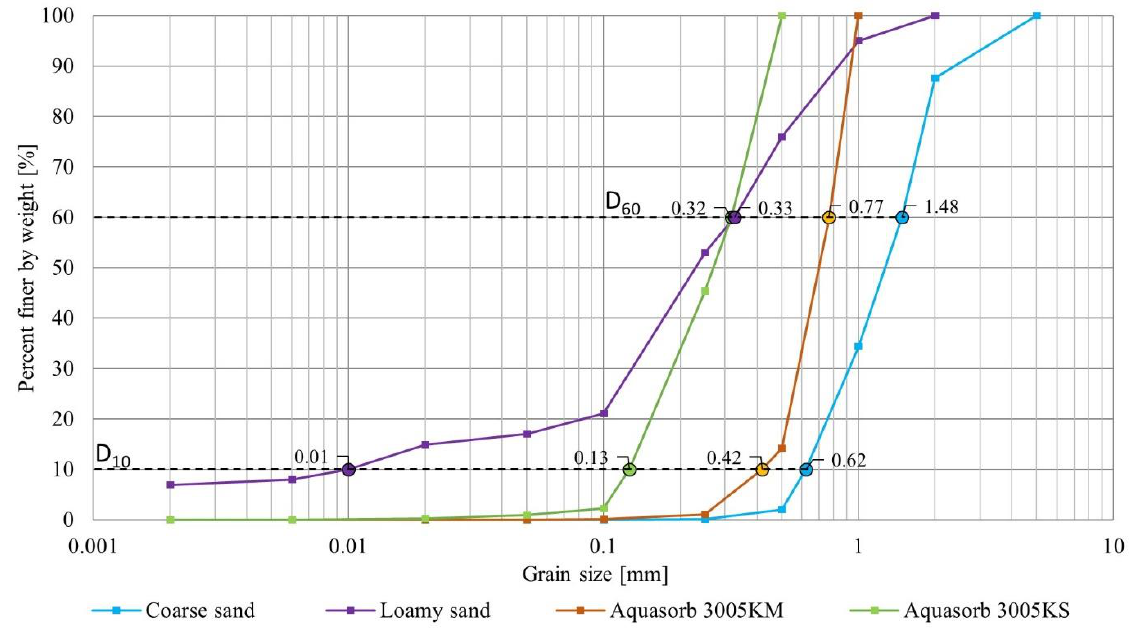
Figure 2. Grain size distributions of the tested SAP and soil.